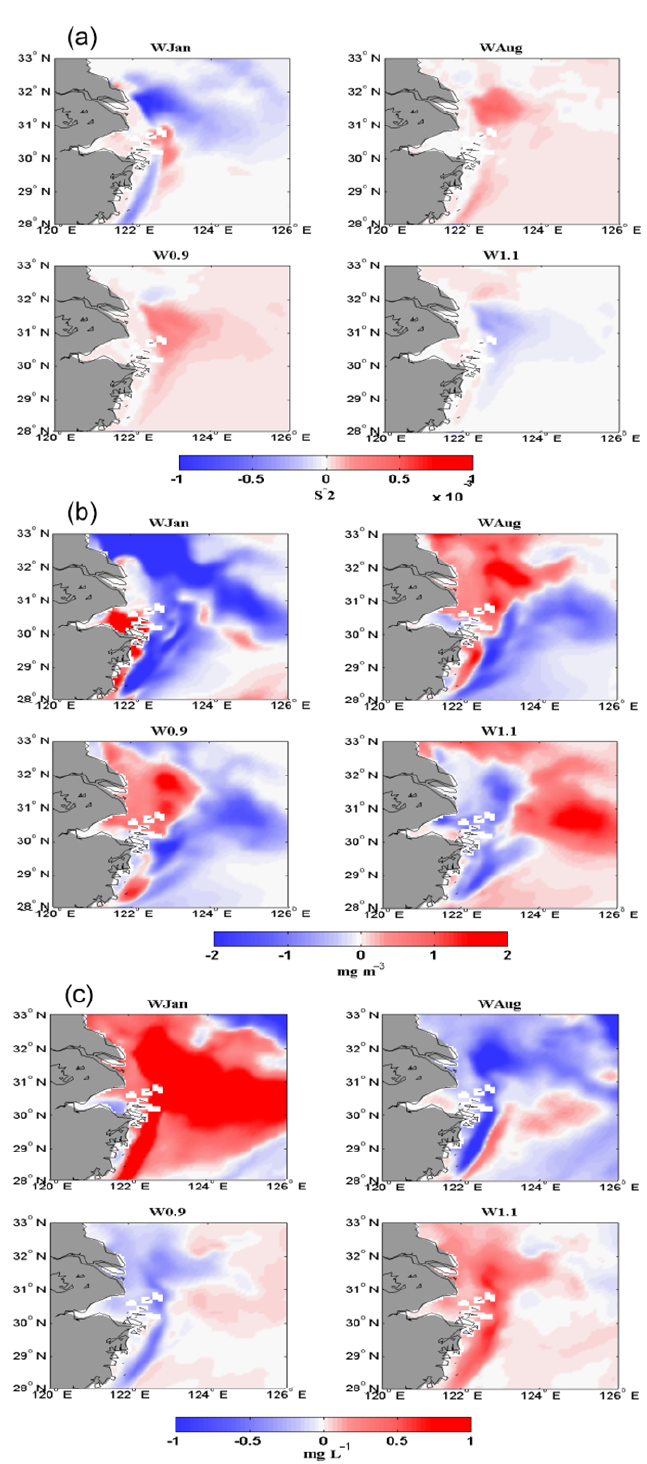
Figure 13. (a) The deviation in summer (7–9 months) stratification( N 2 ) of wind variation runs from the base model. (b) The deviation in summer (7–9 months) chlorophyll concentration of wind variation runs from the base model. (c) The deviation in summer (7–9 months) bottom dissolved oxygen concentration of wind variation runs from the base